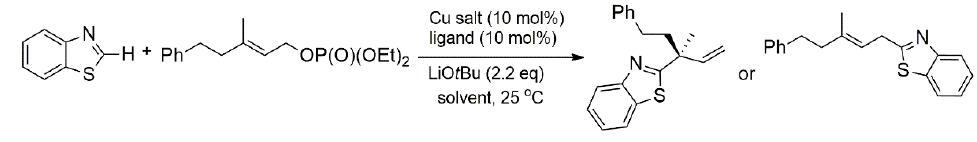
Scheme 38. Enantioselective allylic alkylation